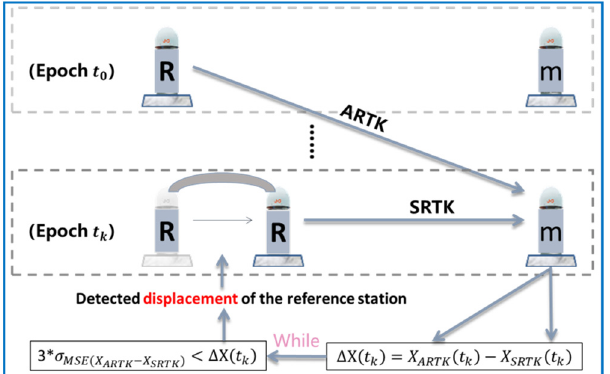
Figure 2. Synchronous real-time kinematic (SRTK) and asynchronous RTK (ARTK) models used to detect the displacement of the reference station (“R” represents the reference station and “m” represents the monitoring station).